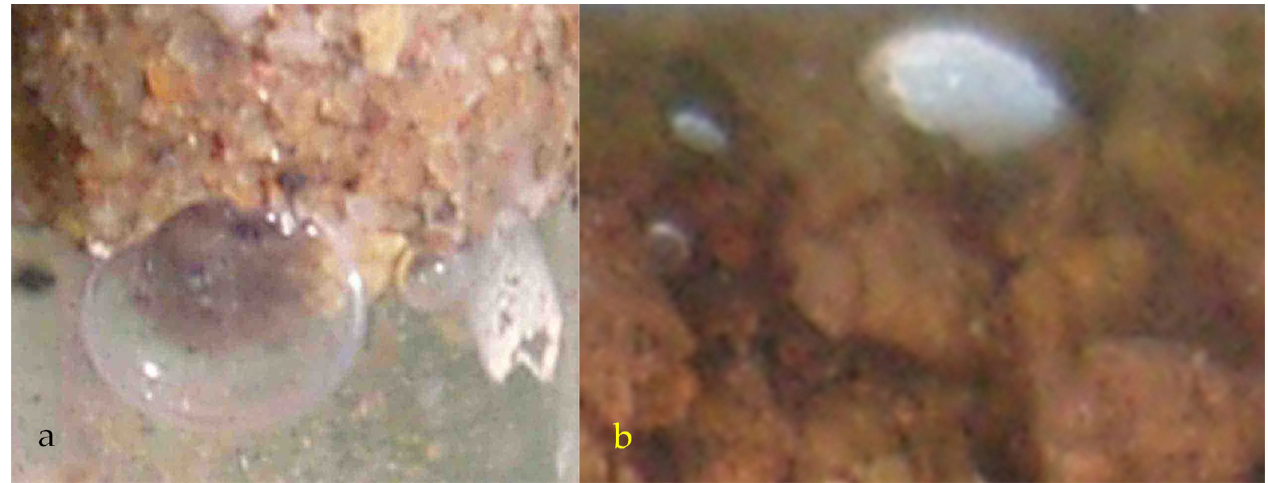
Figure A16. Permeability loss associated with rising gases. ( a ), Unconsolidated quartz sand in a rising water column, showing pore throat blockage by rising gas (air) bubbles. Field of view = 1.5 cm; ( b ), Clay showing clod structure, with clay clods separated by a pore network. Water is flowing through the clay via the porosity. Rising gas bubbles accumulate in the pores and can block the pore throats. Field of view = 5 mm.